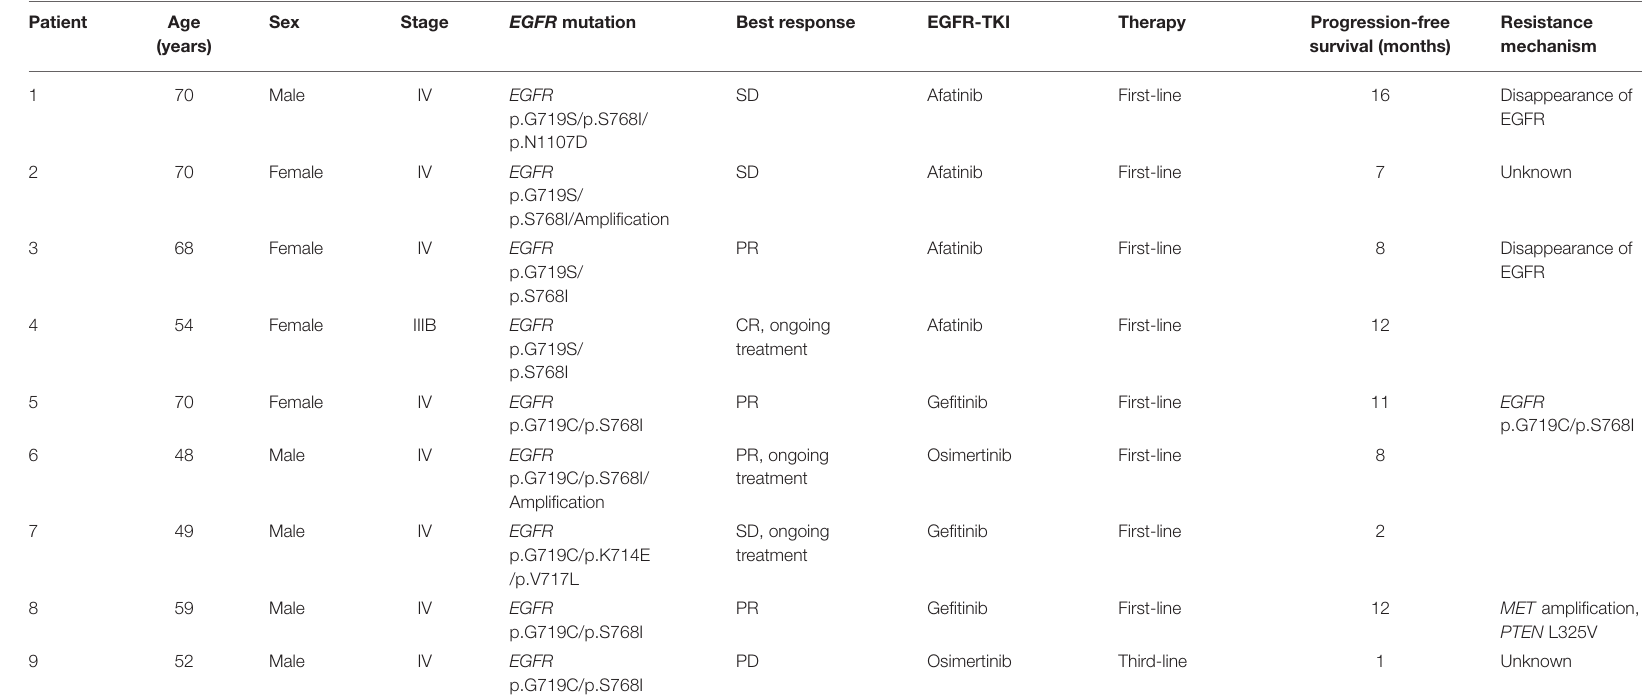
PD, progressive disease; PR, partial response; SD, stable